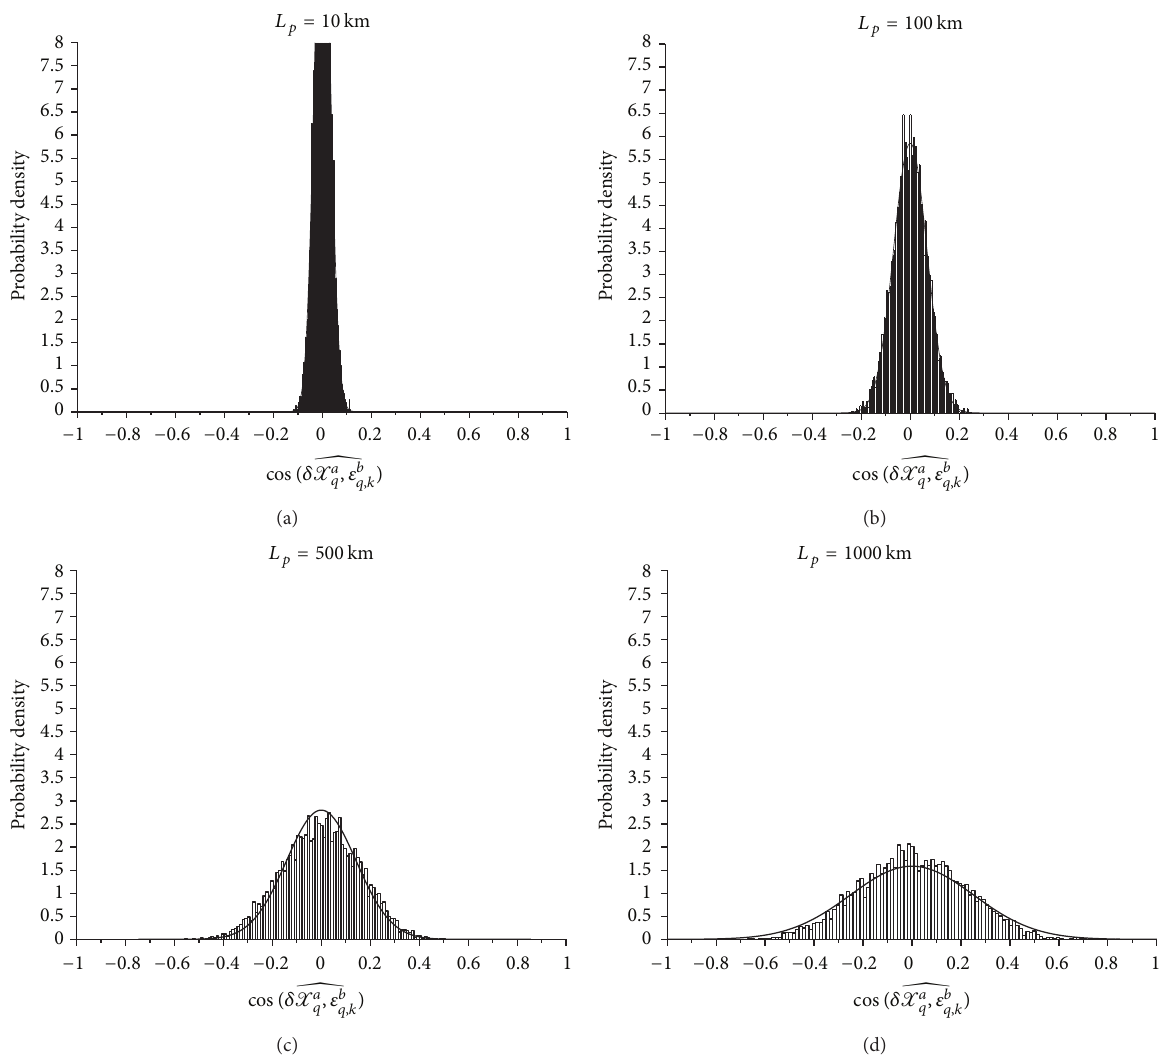
̂ (𝛿 X 𝑎 , 𝜀 𝑏 ) , the cosine of the angle between the analysis increment 𝛿 X 𝑎 Figure 11: Histogram of cos 𝑞 𝑞,𝑘 from the EnKF (and valid here for the PF due to the equivalence in the Gaussian setting), for the various length-scales (a) 𝐿 𝑝 = 10 km, (b) = 100 km, (c) 𝐿 = 500 km, and (d) 𝐿 = 1000 km, for the dimension set to 𝑛 = 1000 𝐿 𝑝 𝑝 𝑝